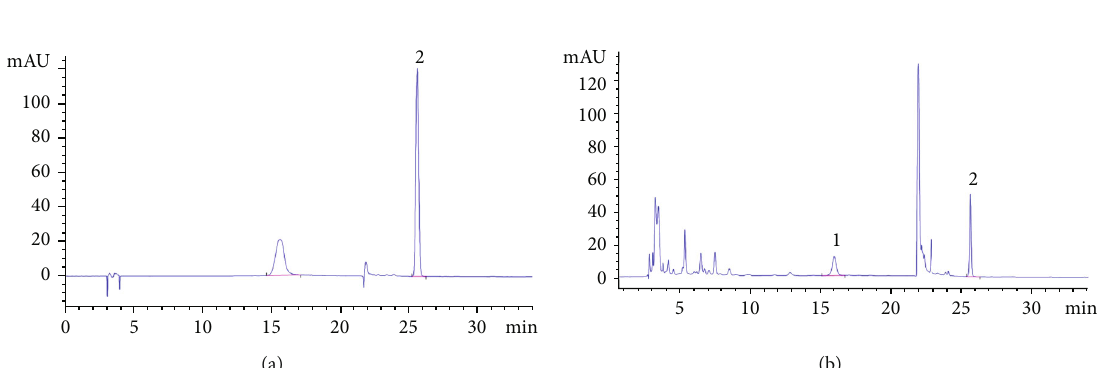
Figure 1: HPLC chromatogram of Moutan Cortex reference substance (a) and sample (b) ((1) paeoni fl orin, (2)